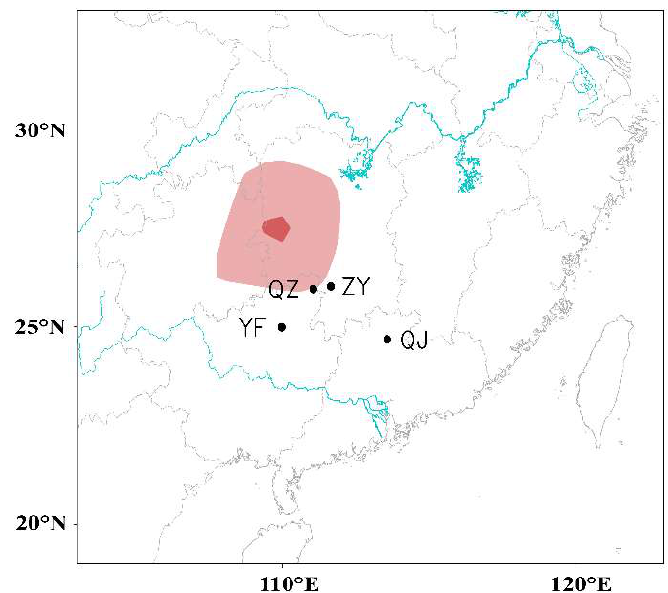
Figure 6. Simultaneous correlation map between WBPH immigration volume in the northern part of southern China and precipitation during 16 May–15 June. The light-trap catches from four PPSs, namely, Yongfu (YF), Quanzhou (QZ), Ziyuan (ZY), and Qujiang (QJ), during 16 May–15 June were summed each year as the WBPH immigration volumes in 1978–2003. The light and dark red areas indicate significance at the 1% and 5% levels,